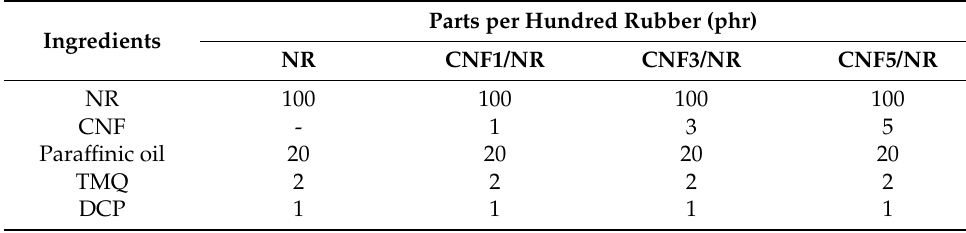
Table 1. Formulation of the NR and the CNF/NR